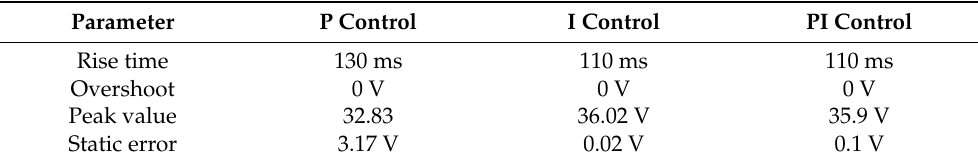
Table 6. Performance evaluation of different controllers, when changing the reference value U ref from 16 V to 36 V. Parameter P Control I Control PI